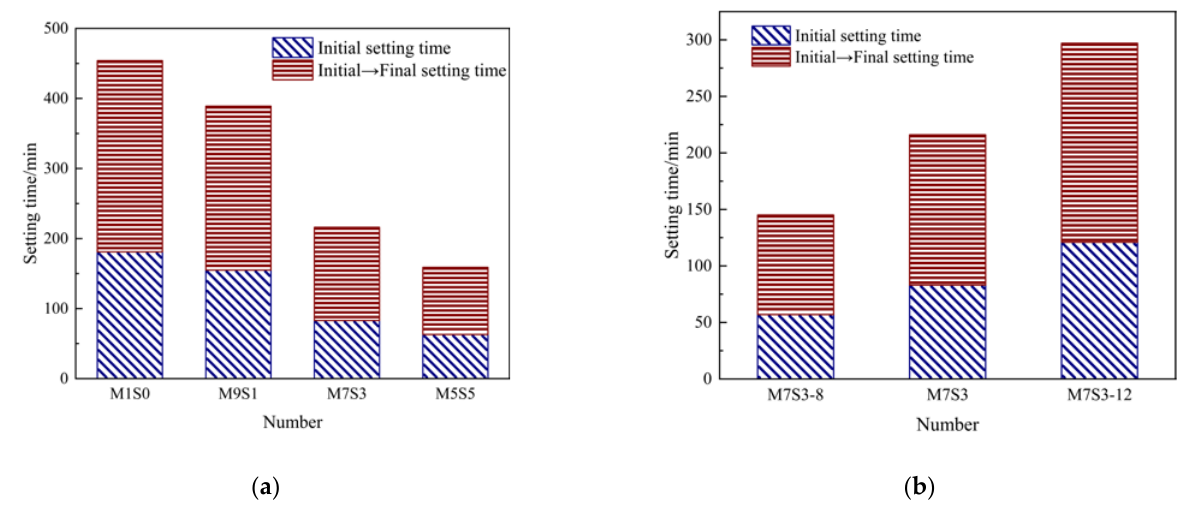
Figure 3. Setting time of AAMS composite cementitious materials. ( a ) Different slag contents. ( b ) Different Na 2 O contents.